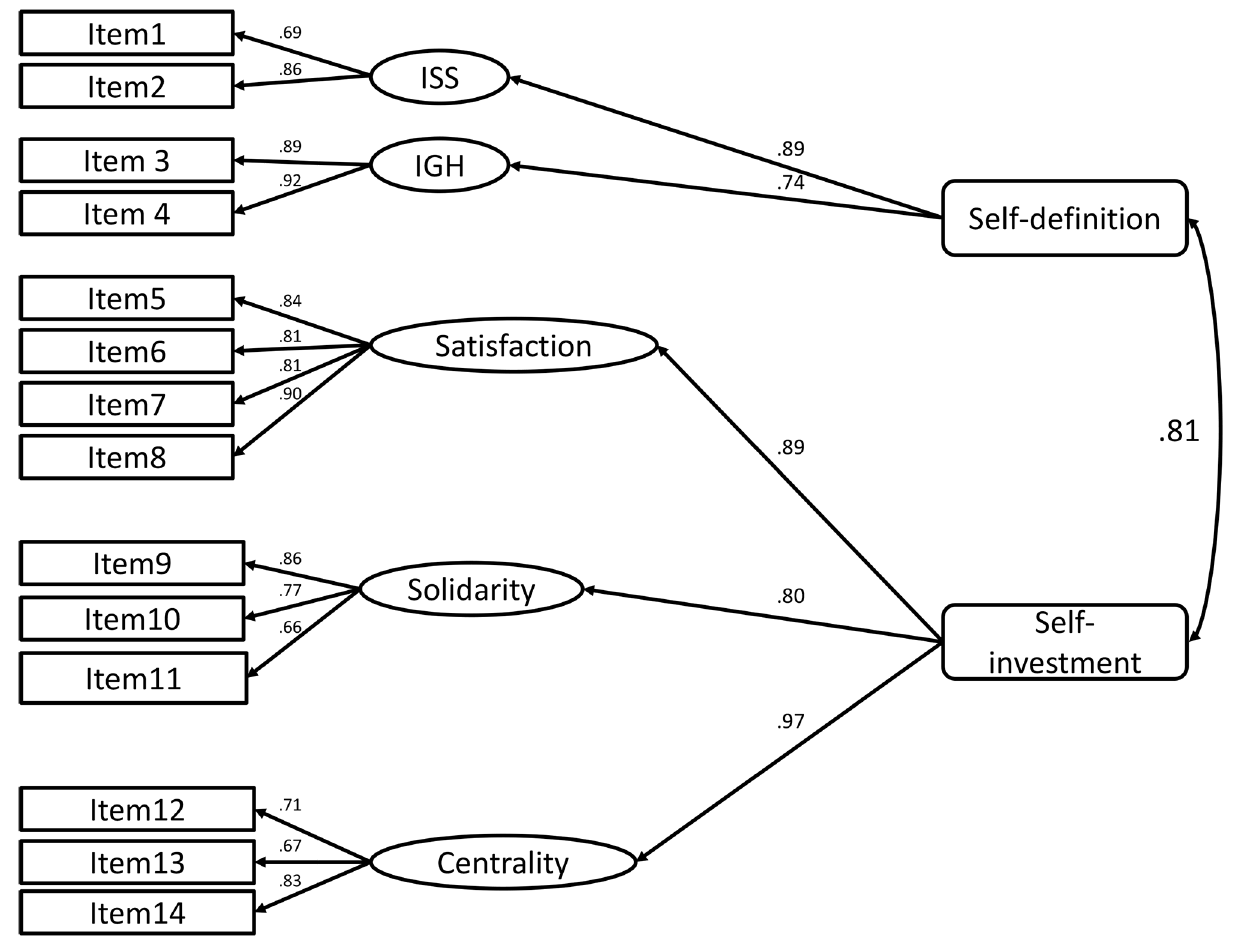
Figure 1. Proposed measurement model for European identification. Note. ISS = individual self-stereotyping; IGH = in-group homogeneity. For all coefficients p